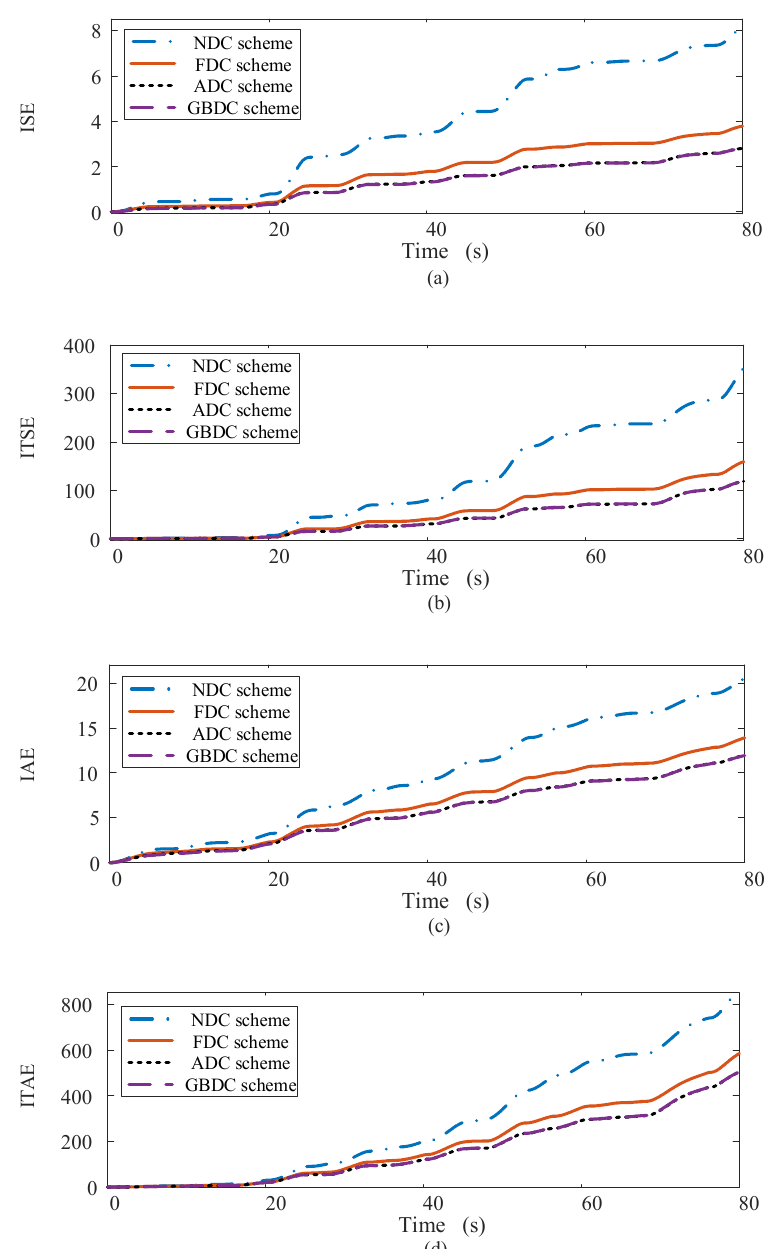
Figure 16. Indices of frequency deviation: ( a ) ISE; ( b ) ITSE; ( c ) IAE; ( d ) ITAE.